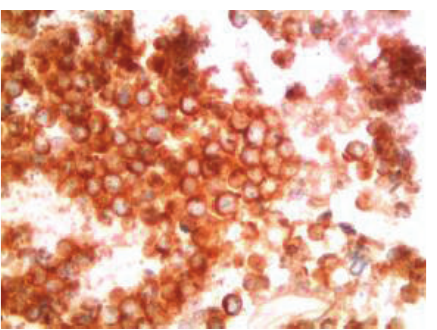
Figure 6: Malignant cells display uniform and diffuse cytoplas- mic immunoreactivity with synaptophysin, supporting a neuroen- docrine phenotype (synaptophysin immunocytochemistry, Cell Block, 630x).